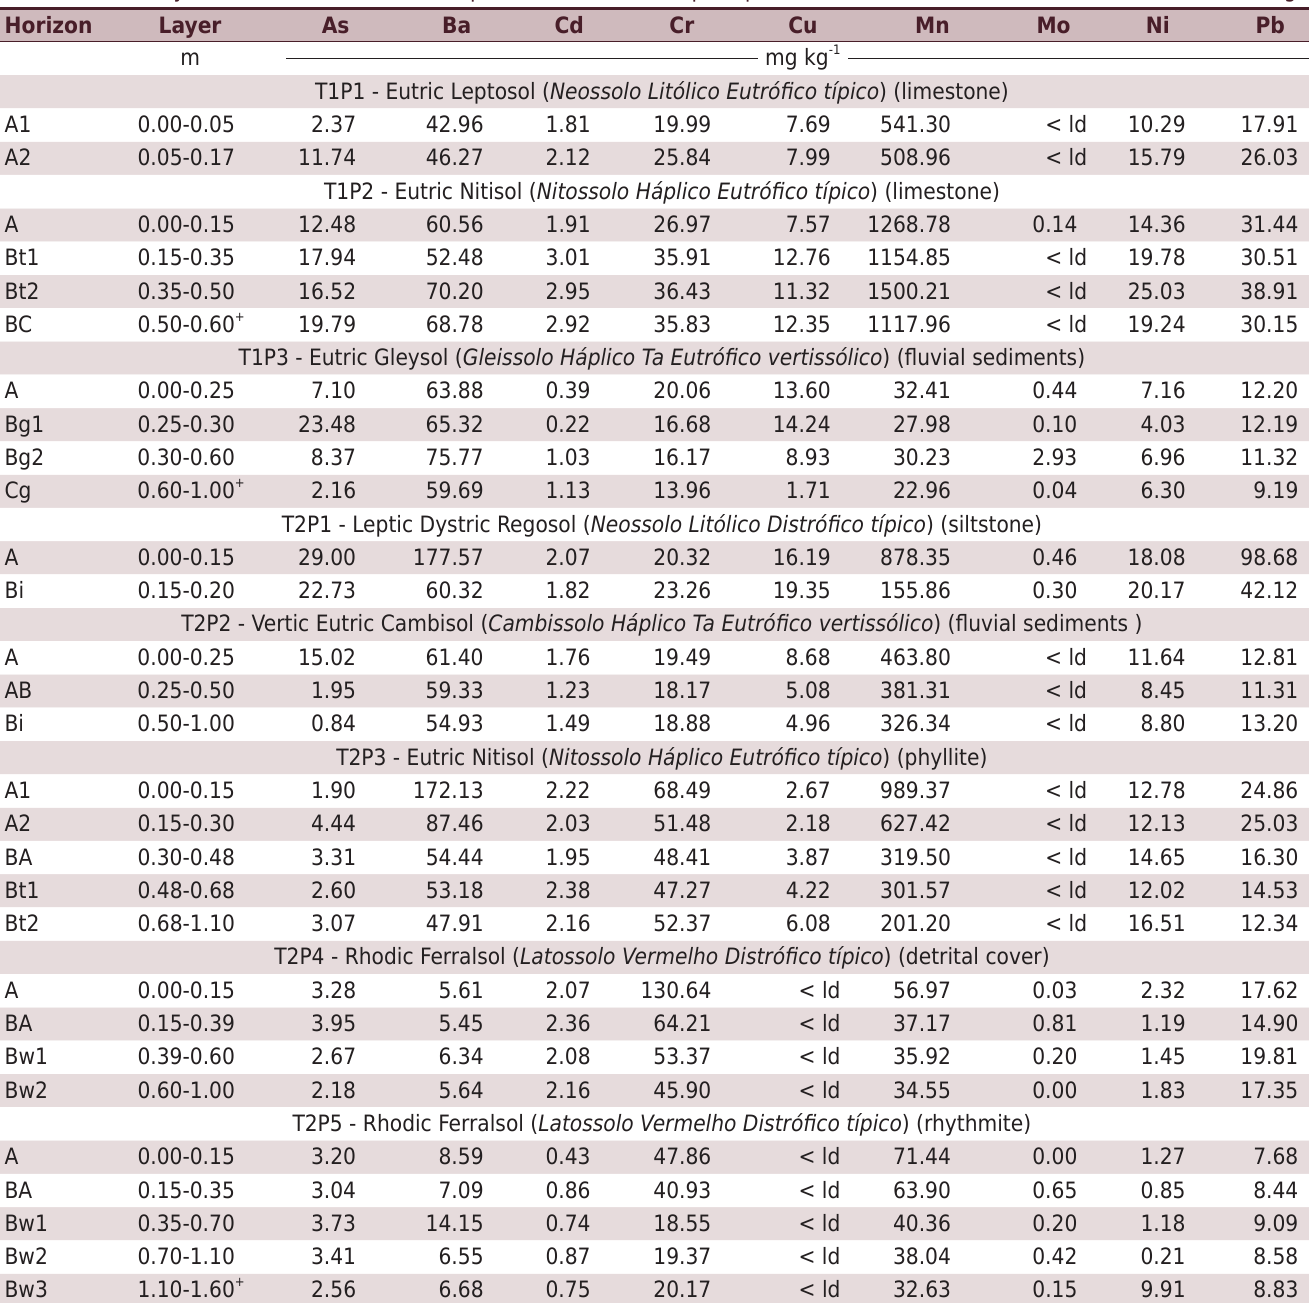
Table 3. Potentially toxic element contents in soil profiles from the lithotoposequences located in the Montes Claros (MG, Brazil) microregion Horizon Layer As Ba